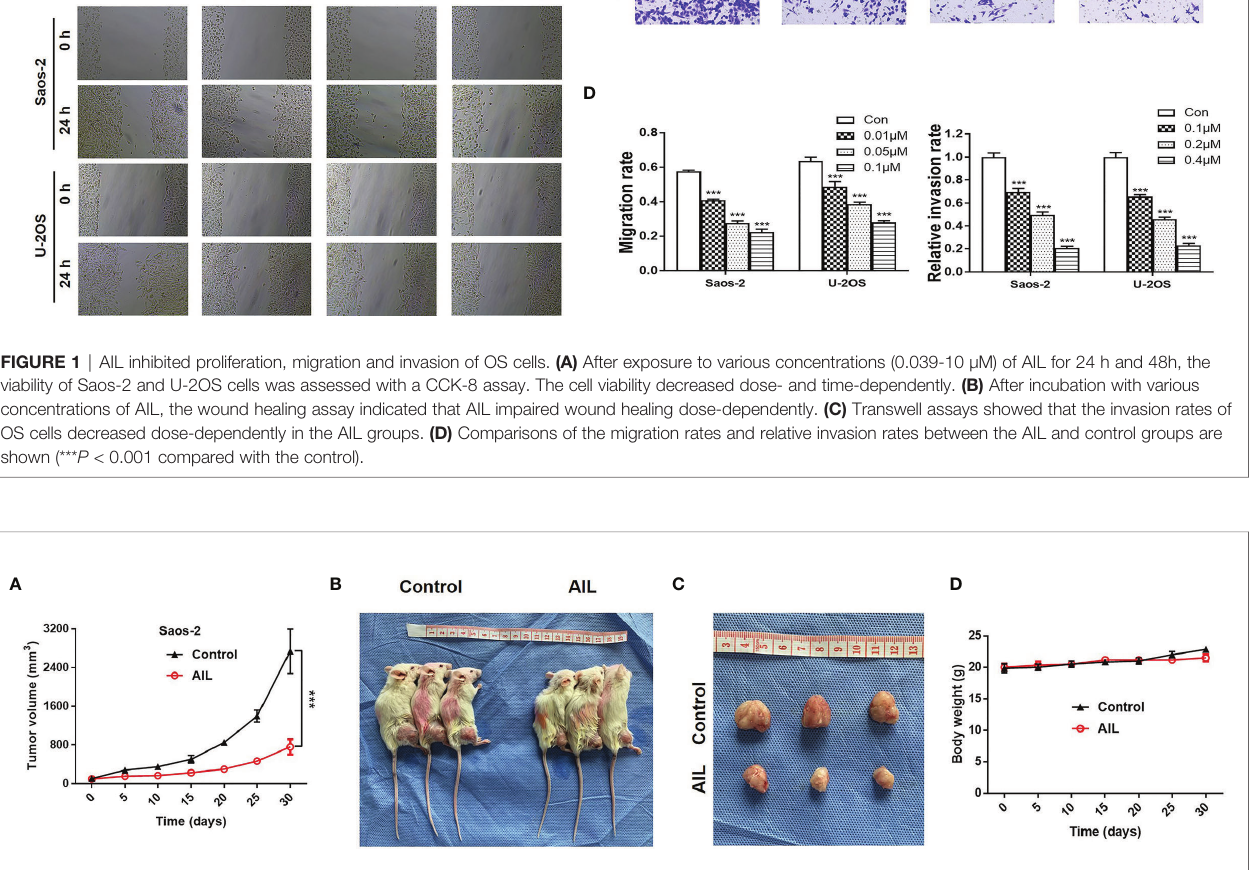
FIGURE 2 | AIL inhibited subcutaneously xenografted tumor growth. (A) Saos-2 tumor-bearing mice were treated with AIL or DMSO intraperitoneally. The tumor volumes were measured every 5 days, growth curves for tumor proliferation were drawn accordingly (*** P < 0.001). (B, C) Mice were sacri fi ced and tumors were harvested (30 days after treatment), the mean tumor volume in AIL-treated mice and DMSO-treated mice was 2739 ± 796 mm 3 and 760 ± 282 mm 3 , respectively (*** P < 0.001). (D) There was no signi fi cant difference in mice weight between the two